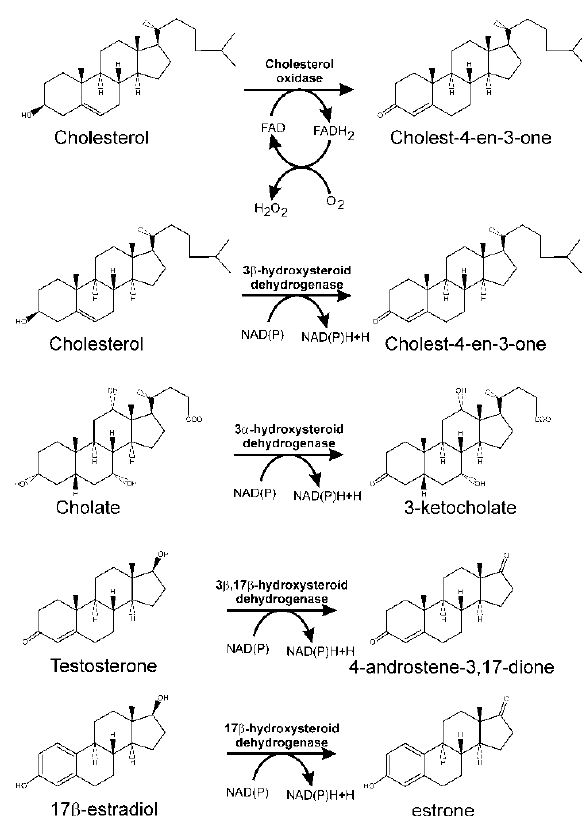
Figure 3. Initial reactions catalysed by cholesterol oxidase and different hydroxysteroid dehydrogenases in steroid degradation through the 9,10- seco pathway.